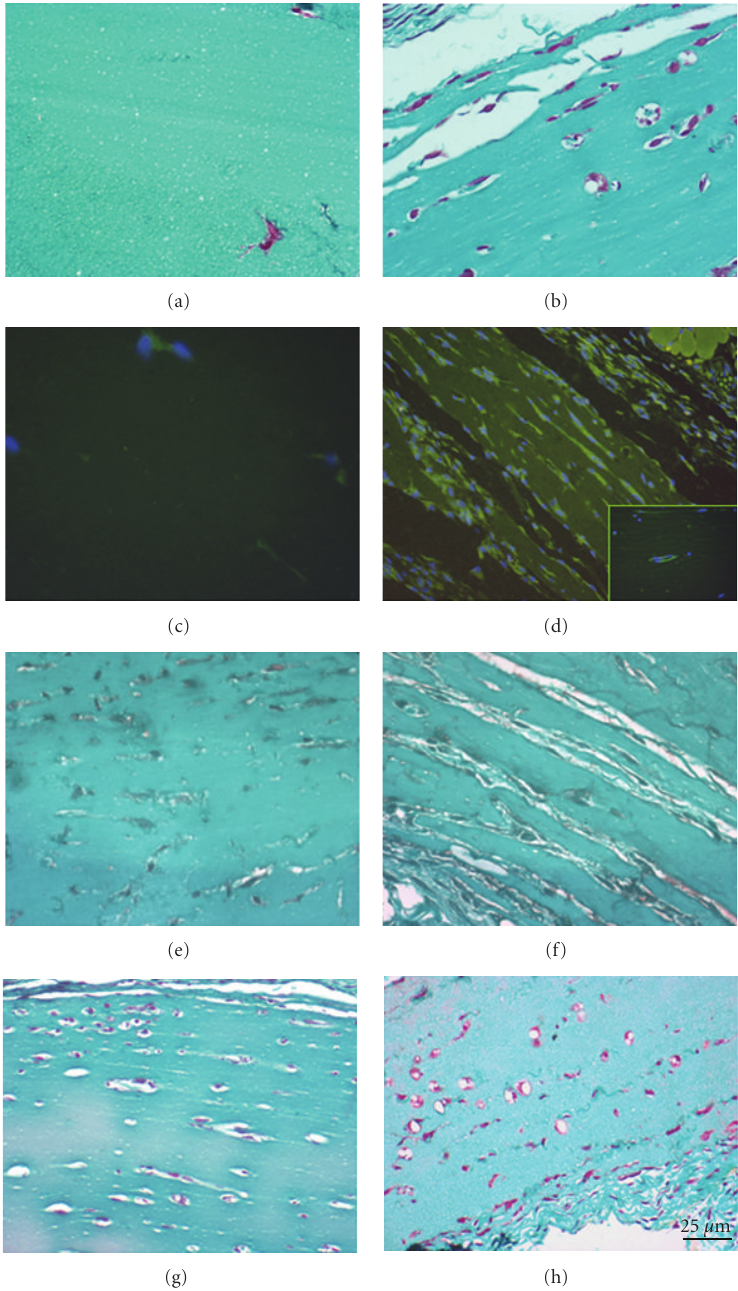
Figure 2: In vivo angiogenesis gel plug assay. AT-SCs isolated from ubiquitously GFP-expressing mice were mixed with Cultrex and injected subcutaneously into CD1 recipient. After 1 week, gel plugs were analyzed and capillary density was determined by Masson Trichromic stain (b) and anti-GFP immunohistochemistry (d). Control animals received gel plugs containing saline solution (a)–(c). Masson trichromic stain of implanted gel plugs containing nonconditioned serum-free medium (e) and conditioned medium from AT-SCs cultures (f); AT-SCs were genetically modified by Ad-GFP (g) and Ad-SDF-1 (h). The number of endothelial-like structures formation was slightly improved by SDF-1 overexpression, but the di ff erence versus the control group (Ad-GFP) did not achieve statistical significance ( P -value ≥ . 05).